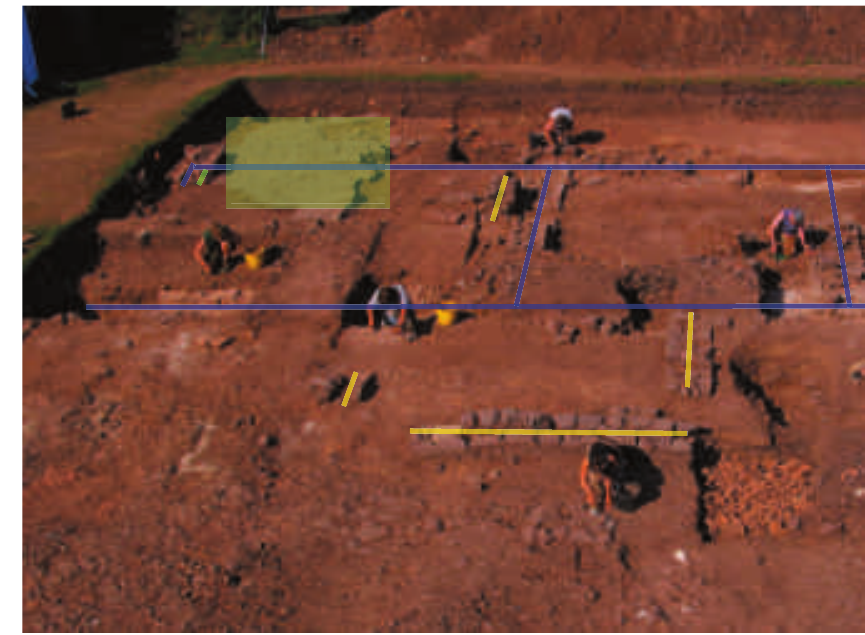
Figure 3 Photograph of the 2008 trench, with exposed Roman and “intermediate’”structural phases highlighted (Blue: Roman “store-building”; Green: alterations to “store-building”; Yellow: intermediate phase walls